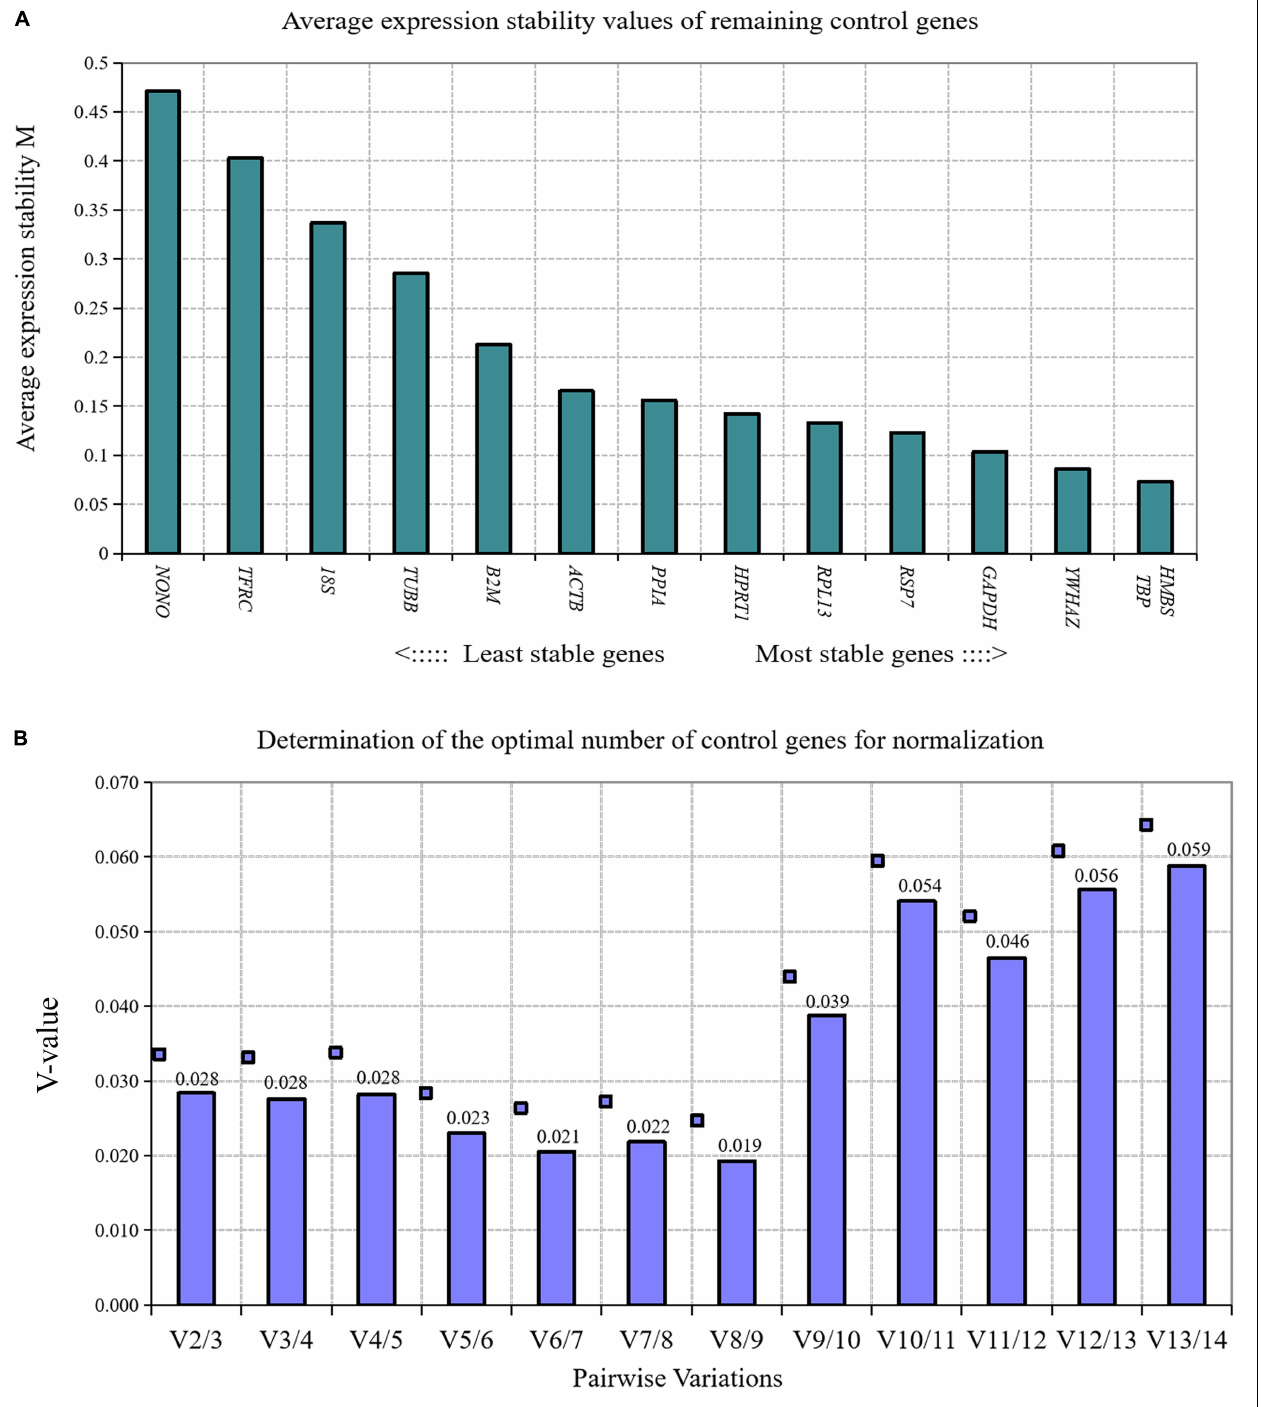
FIGURE 2 | GeNorm analysis of 14 reference genes in directly isolated primary preadipocytes and mature adipocytes. (A) Expression stability analysis. The most stably expressed genes have lower M values. TBP and HMBS were the two best reference genes; (B) Pairwise variation analysis. Determination of the optimal number of reference genes required for normalization calculated by pairwise variation analysis between normalization factors NF n and NF n + 1 . According to geNorm algorithm, two reference genes were needed.